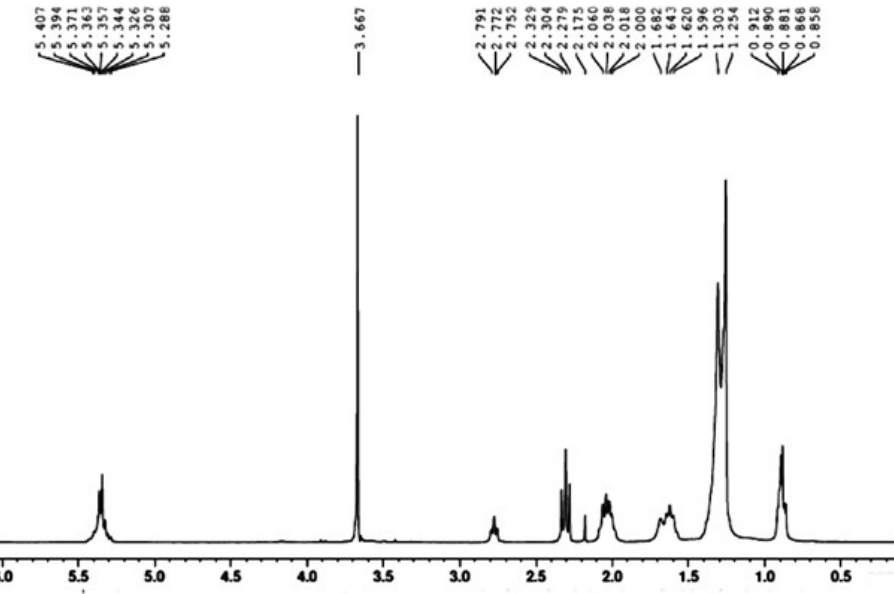
Figure 7. 1 H-NMR spectroscopy confirming the synthesis of biodiesel through various important peaks.